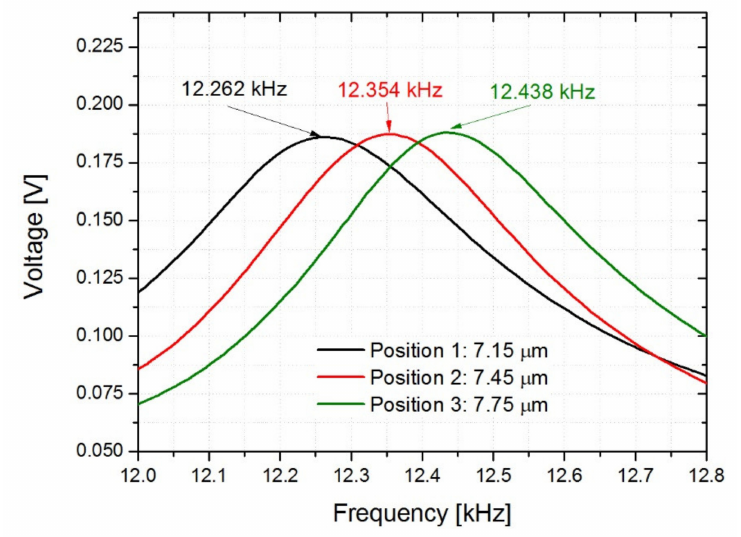
Figure 5. Open-loop measurements of the PZT-1 actuator in contact with PLA sample with a displacement of 0.3 µ m between